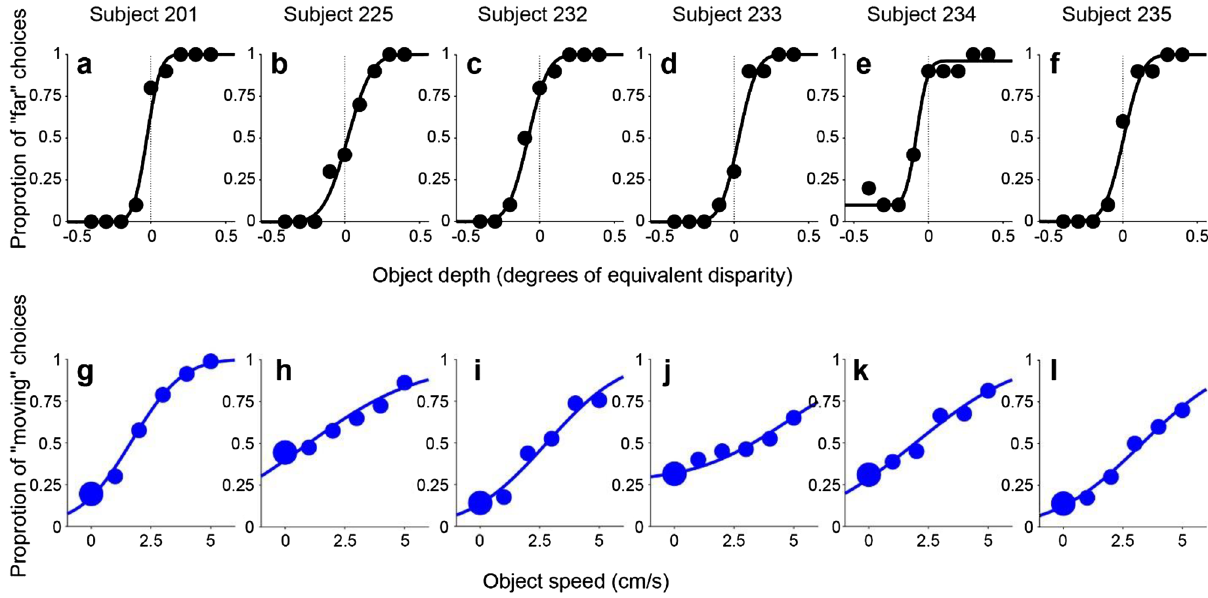
Figure 9. Subjects can judge depth and scene-relative motion of an object based on size cues. ( a – f ) Depth psychometric functions for Control Experiment 1. Subjects can judge depth of a stationary object based only on size information when the object is presented monocularly. ( g – l ) Psychometric functions for Control Experiment 2, in which subjects reported whether the object was moving or stationary relative to the scene. Proportion of “moving” choices is plotted as a function of the speed of the object’s motion relative to the scene (when speed = 0, the object is stationary in the scene). All subjects can detect object motion relative to the scene when the object is presented monocularly during simulated